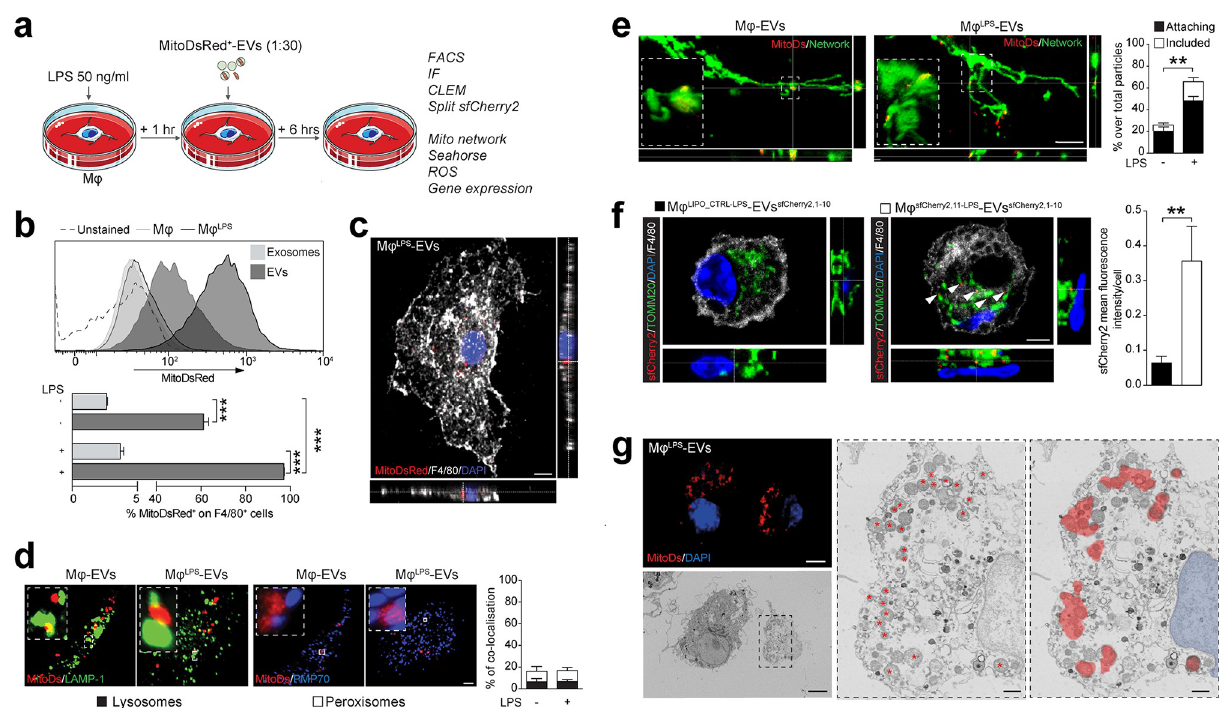
Fig 6. EV-associated mitochondria integrate in the host mitochondrial network. (a) Experimental setup for the functional in vitro studies of EVs on M φ . M φ LPS were treated with EVs spontaneously released from MitoDsRed + NSCs (ratio 1:30). Uptake of MitoDSred + particles and functional analyses of M φ were assessed at 6 hours posttreatment. (b) Flow cytometry–based representative density plots of M φ and M φ LPS at 6 hours after treatment with MitoDsRed + EVs or exosomes. Data are mean % ( ± SEM). ��� p � 0.001. N = 3 independent biological replicates. (Data available in S3 Data). (c) A representative confocal image (orthogonal section (XY) of Z-stacks is shown) of M φ LPS treated with EVs at 6 hours, showing uptake of MitoDSred + mitochondria. Nucleus is stained with DAPI (blue). Scale bar: 3 μ m. (d) Representative spinning disk micrographs (maximum intensity projection of Z- stacks) and quantification of MitoDsRed + EVs (red) co-localising with the lysosomal marker LAMP1 (green) or the peroxisomal marker PMP70 (blue) in M φ . Data are mean values ( ± SEM). � p < 0.05. N � 10 cells per condition (2 independent experiments). Scale bars: 2 μ m. (Data available in S3 Data). (e) Representative spinning disk images (orthogonal section (XY) of Z-stacks is shown) and relative quantification showing MitoDSred + EVs (red) attached or included in the mitochondrial network of M φ (previously stained with MitoTracker Green FM). Inset: magnified 3D surface reconstruction of included mitochondria (Imaris Software). Data are percentage of either attaching or including particles over total MitoDSred + particles in M φ ( ± SEM). �� p < 0.01. N � 5 cells per condition from N = 3 independent experiments. Scale bars: 5 μ m. (Data available in S3 Data). (f) Representative images (orthogonal section (XY) of Z-stacks) of a split FPs showing EVs sfCherry2,1–10 fusing with M φ sfCherry2,11 (in red) juxtaposed to the host TOMM20 + mitochondrial network (in green) at 6 hours from EV treatment. Nuclei are stained with DAPI (blue). Data are mean values ( ± SEM). �� p < 0.01. N = 10 cells per condition. Scale bars: 5 μ m. (Data available in S3 Data). (g) Representative CLEM image of M φ LPS treated with MitoDsRed + -EVs for 6 hours. Top left panel, confocal image (orthogonal section (XY) of 1 Z-stack) showing MitoDsRed + EVs (red) and M φ LPS nuclei (blue); bottom left panel, scanning EM image of the M φ LPS depicted in the confocal image. Scale bars: 5 μ m. Middle panel, magnified ROI of the M φ LPS mitochondrial network ultrastructure; right panel, superposition of confocal and scanning EM images showing co-localisation of the MitoDsRed + mitochondria (red) with the host M φ LPS mitochondrial network. Nucleus is pseudocolored in blue. Asterisks show MitoDsRed + mitochondria. Scale bars: 1 μ m. CLEM, correlative- light electron microscopy; DAPI, 4 0 ,6-diamidino-2-phenylindole; EV, extracellular vesicle; LPS, lipopolysaccharide; ROI, region of